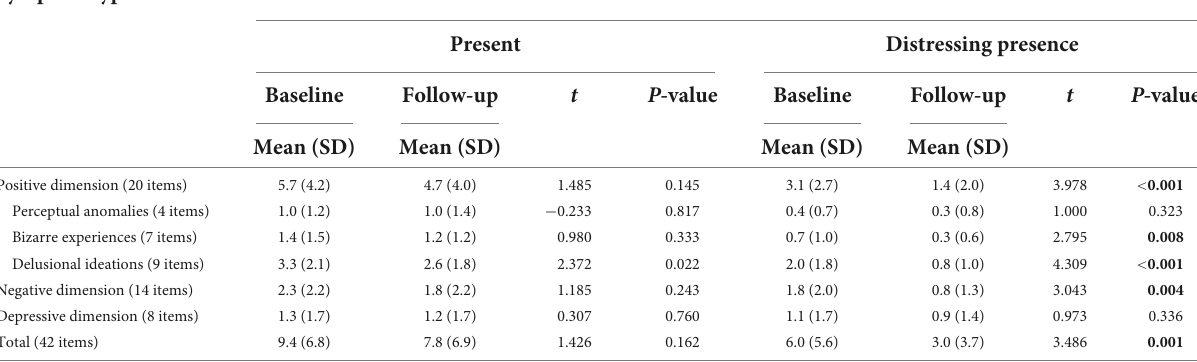
TABLE 2 Number of endorsed present and distressing items measured with the CAPE at baseline and follow-up ( n = 42). Symptom type a Number of endorsed items